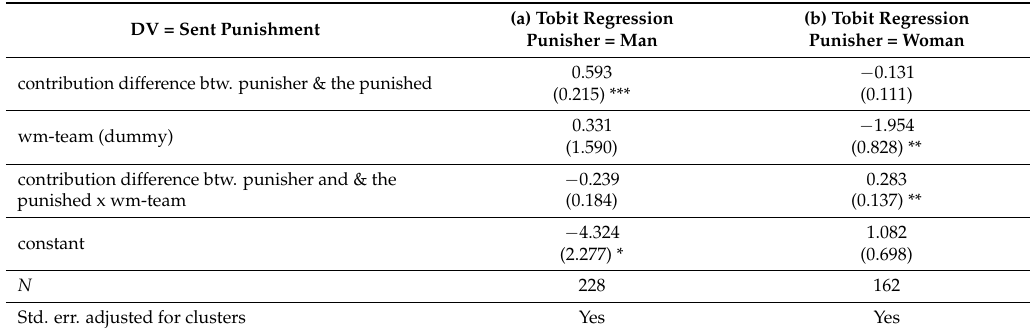
Table A1. Regression results on sent punishment for (a) men and (b)